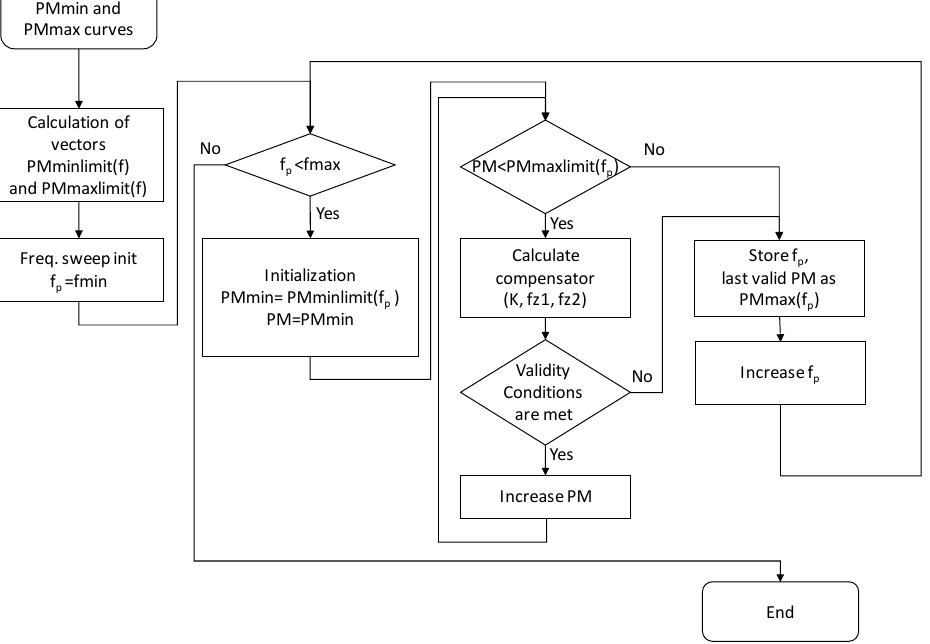
Figure 7. Flowchart of the procedure to calculate the limits of the performance space ( f c , PM )